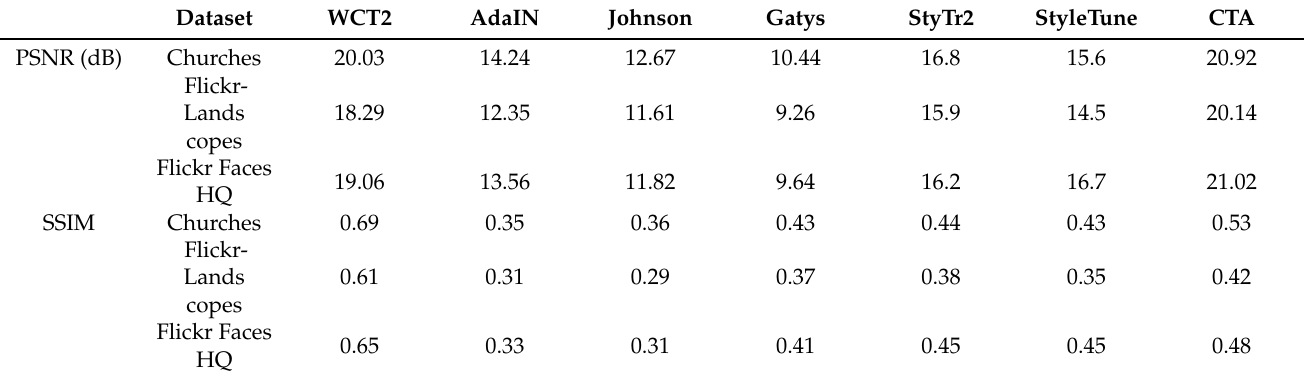
Table 1. Performance indicators of different models (results are retained to two decimal